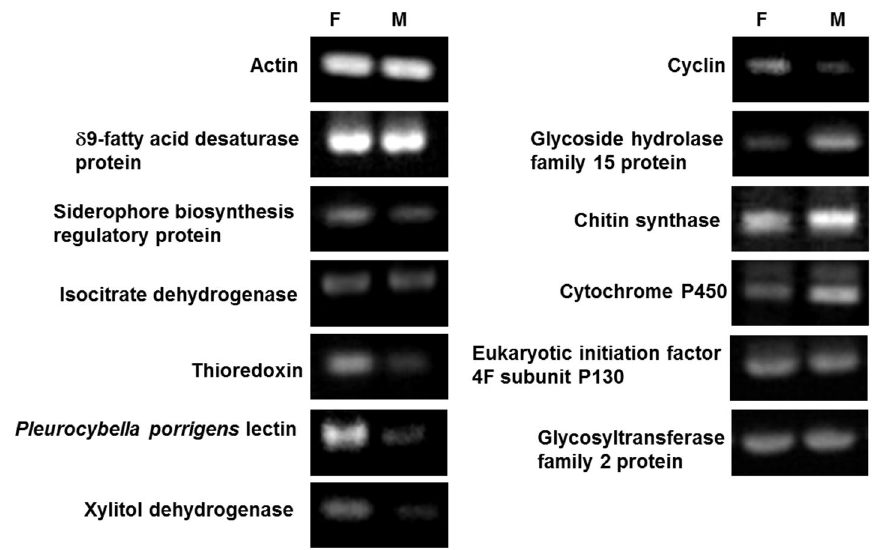
Figure 3. Semi-quantitative RT-PCR analysis. RT-PCR analysis of the expression of 13 genes, including an internal control: Actin, in fruiting bodies (F) and mycelia (M) of P. porrigens . Primer sequences and PCR product sizes are given in Table 4. doi: